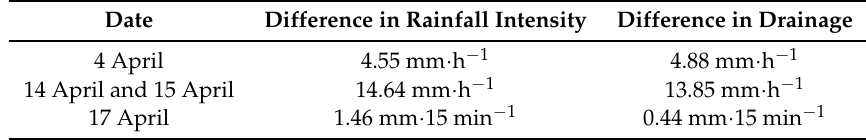
Table 4. Differences in rainfall intensity and drainage between hillslope 1 and hillslope 2 on different